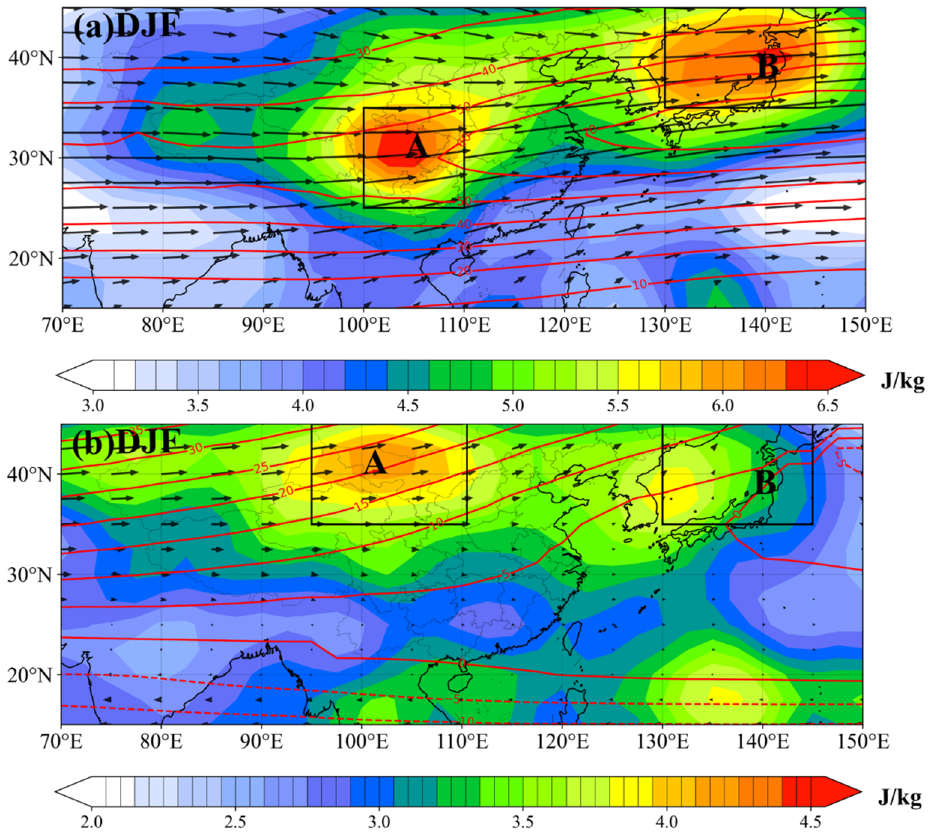
Figure 8. ( a ) Ep (shaded), wind speed (red contours, unit: m s − 1 ) and wind speed vectors (arrows) at 200 hPa. ( b ) All at 25 km.